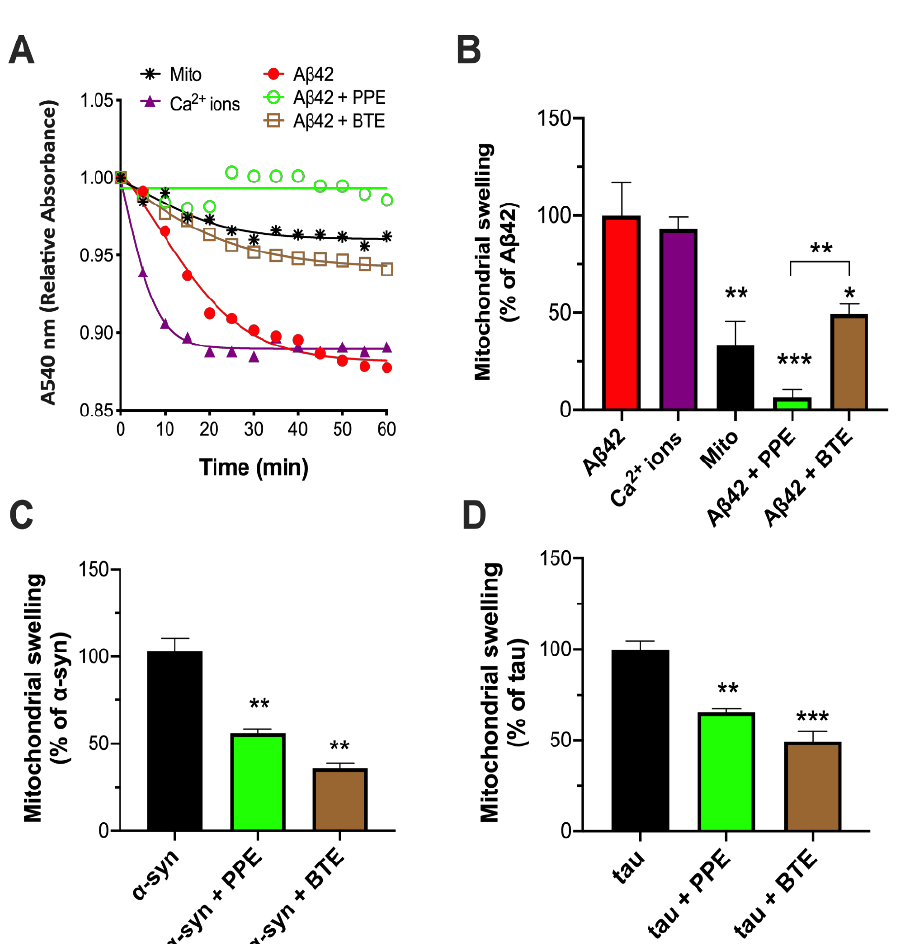
Figure 2. Inhibition of aggregate-induced swelling of isolated mitochondria. Kinetic traces ( A ) of changes in relative absorbance at 540 nm due to swelling of mitochondria upon exposure to 5 µ M A β 42 or 250 µ M CaCl 2 (positive control). Padina pavonica extract (PPE; 1 µ g/mL), black tea extract (BTE; 0.5 µ g/mL) or 0.01% DMSO (solvent control) were incubated with the A β 42 aggregates at RT for 10 min before adding to the mitochondria. The swelling assays were performed over three independent experiments, representative tracings being shown. Maximal swelling over 1 h in presence of PPE and BTE extracts was calculated as a percentage of that induced by 5 µ M A β 42 ( B ), 2 µ M α -syn ( C ) and 1 µ M tau ( D ) oligomers alone. Data are presented as means ± SEM ( n = 3–5); * p < 0.05, ** p < 0.01, *** p < 0.001 relative to protein aggregates alone (one-way ANOVA). Refer to Suppl. Table S1 for F- values and p -values of one- way ANOVA.